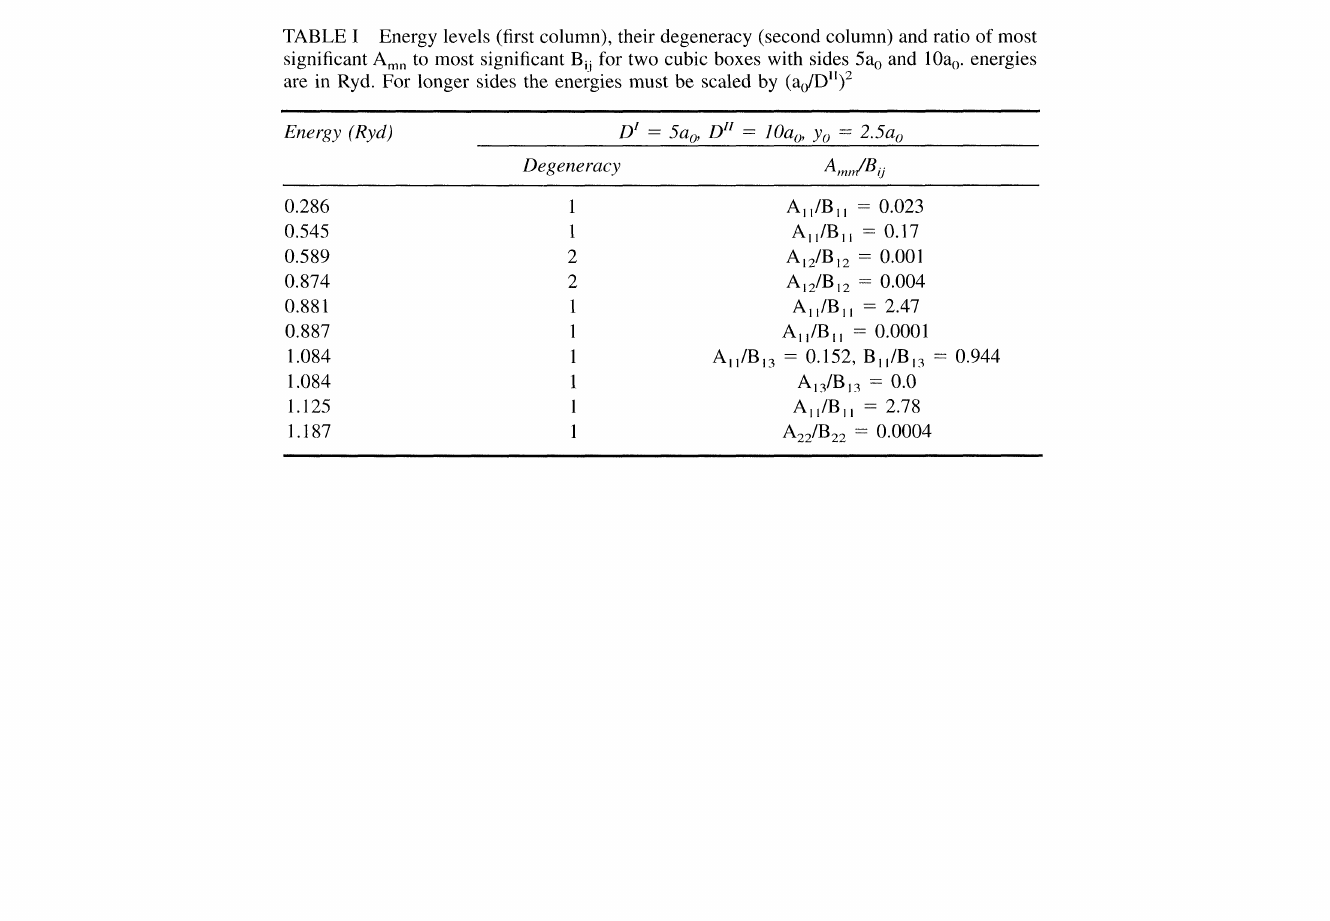
Energy levels (first column), their degeneracy (second column) and ratio of most significant Amn to most significant B. for two cubic boxes with sides 5a and 10a o. energies are in Ryd. For longer sides the energies must be scaled by (ao/Dn) Energy (Ryd)